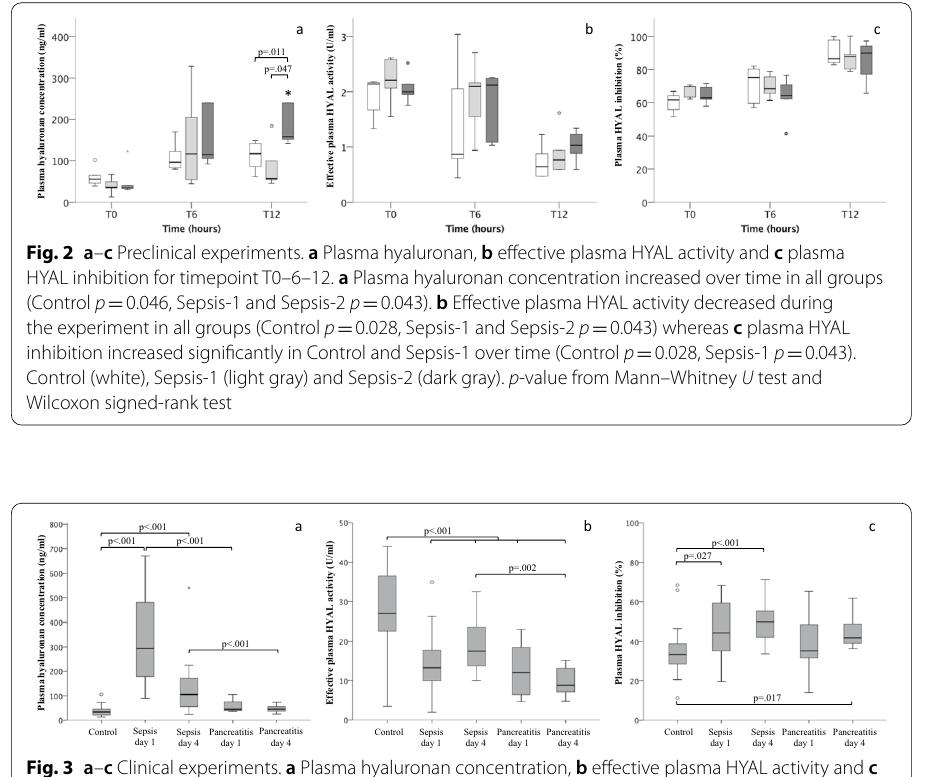
measurements showed a negative correlation between plasma hyaluronan and effective HYAL activity (rs 0.38, p 0.026) and between effective HYAL activity and HYAL = − = inhibition (rs 0.824, p < 0.001; Additional file 1: Fig. S3a–c). Pooled data showed a = − negative correlation between effective plasma effective HYAL activity and HYAL inhibi- tion (rs 0.697, p < 0.01; Additional file 1: Fig. S4a–c) but not between plasma hya- = − luronan concentration and effective HYAL activity ( p 0.091) or plasma hyaluronan = concentration and HYAL inhibition ( p 0.501). =